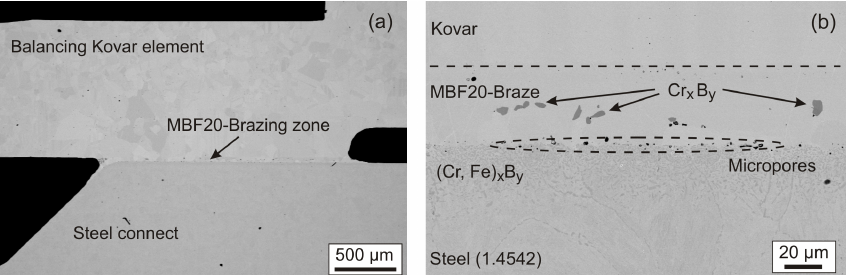
Figure 4. Scanning electron micrographs of steel (1.4542)–Kovar joints brazed with MBF-20 showing an overview in (a) and details of the microstructure in (b)